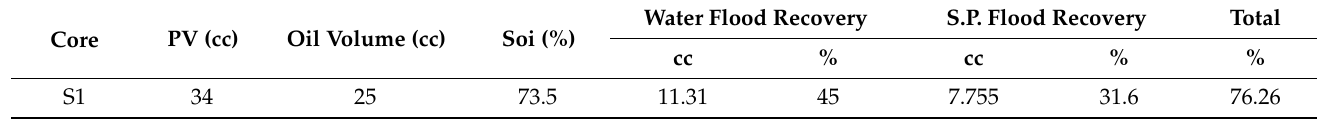
Table 8. Flood Results for Acetone, APG 264, and Xanthan Gum